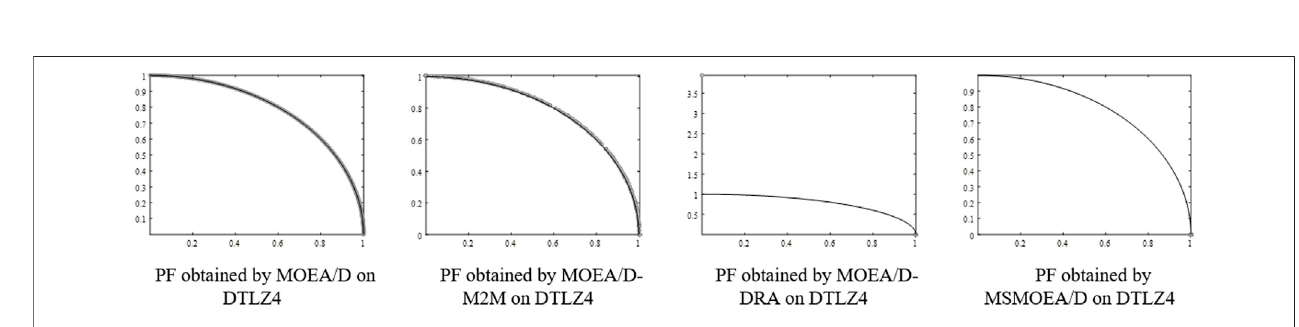
FIGURE 7 | PF obtained by MSMOEA/D and MOEAs on two-objective DTLZ4.